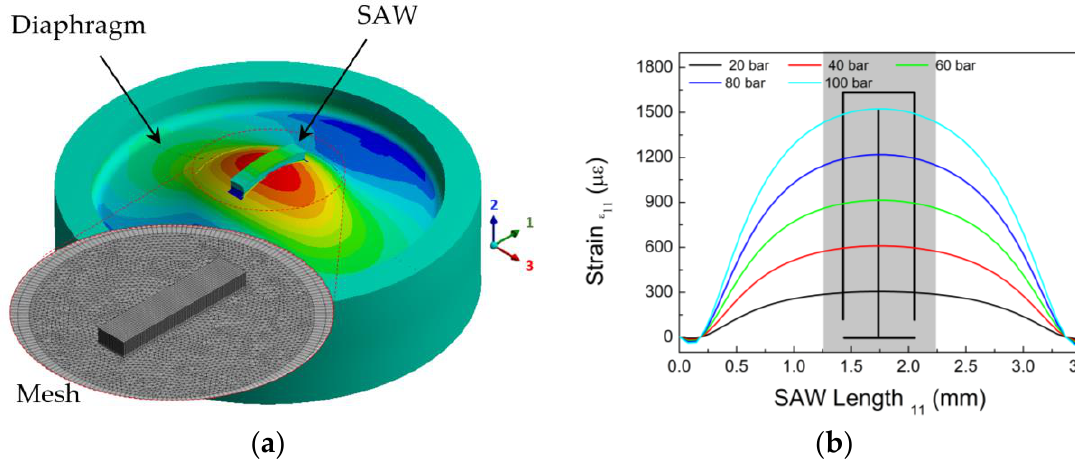
Figure 2. ( a ) Radial strain distribution (in the inset: mesh density close to the SAW device). ( b ) Radial strain distribution on the top surface of the SAW device at increasing pressures.